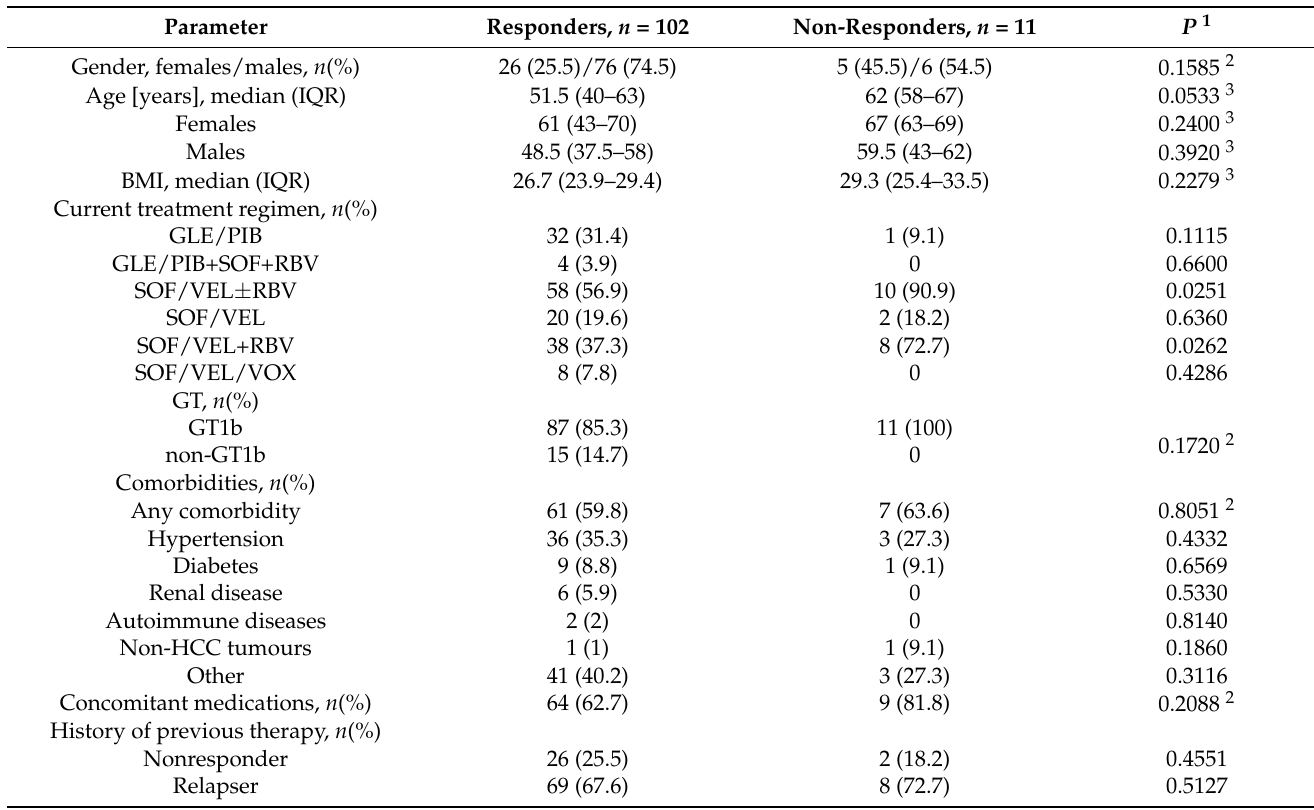
Table 6. The Comparison of Virological Responders and Non-Responders to Antiviral